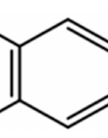
Figure 4. Molecular structure of